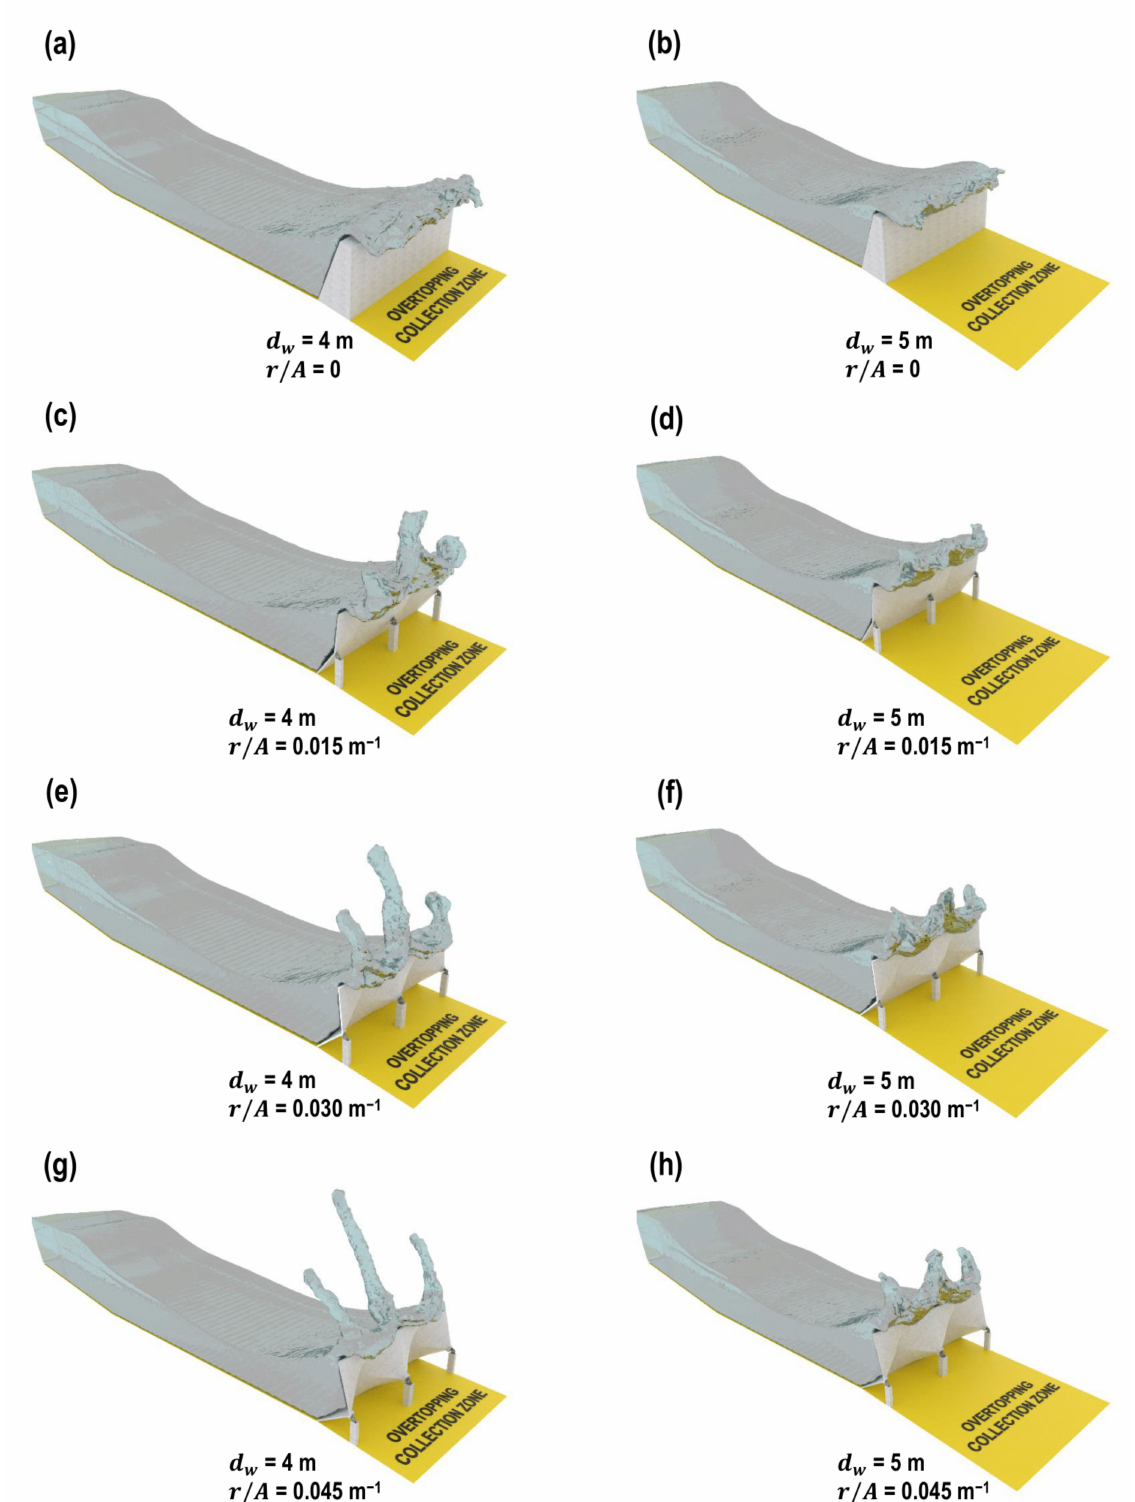
Figure 14. Observations of wave overtopping at approximately t = 50 s pertaining to d w = 4 m and d w = 5 m for ( a , b ) r / A = 0, ( c , d ) r / A = 0.015 m − 1 , ( e , f ) r / A = 0.030 m − 1 , and ( g , h ) r / A = 0.045 m − 1 for Kinetic Umbrellas subject to hurricane wave